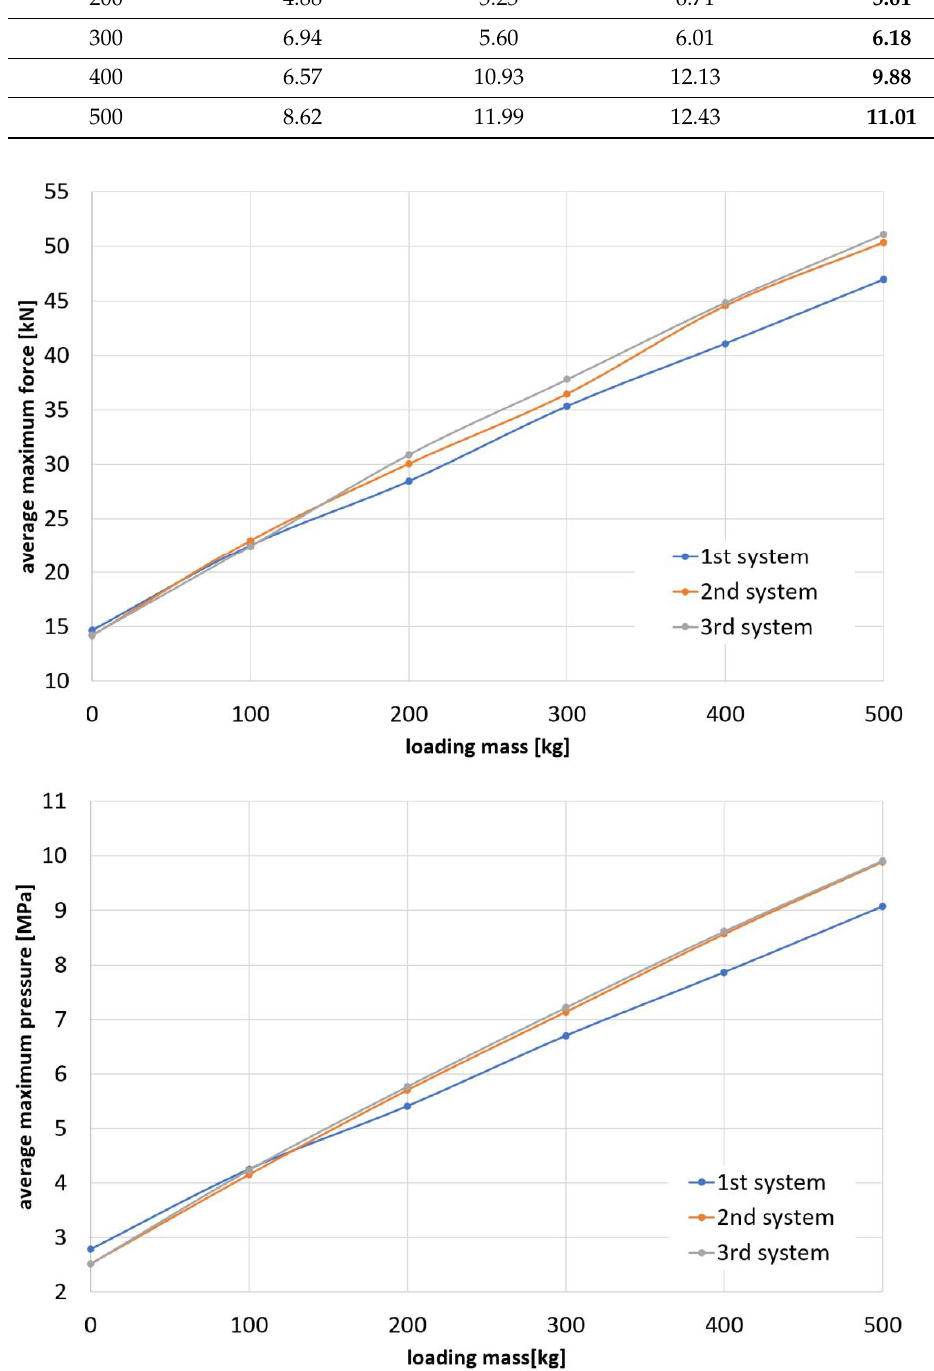
Figure 7. Average values of the maximum recorded pressure and forces as a function of the loading mass.